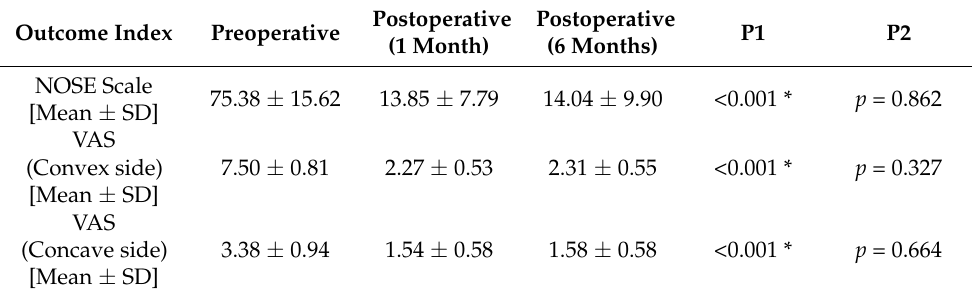
Table 1. Symptoms and nasal cavity space improvement 1 month and 6 months after performing endonasal functional rhinoplasty using an autologous septal cartilaginous batten graft.